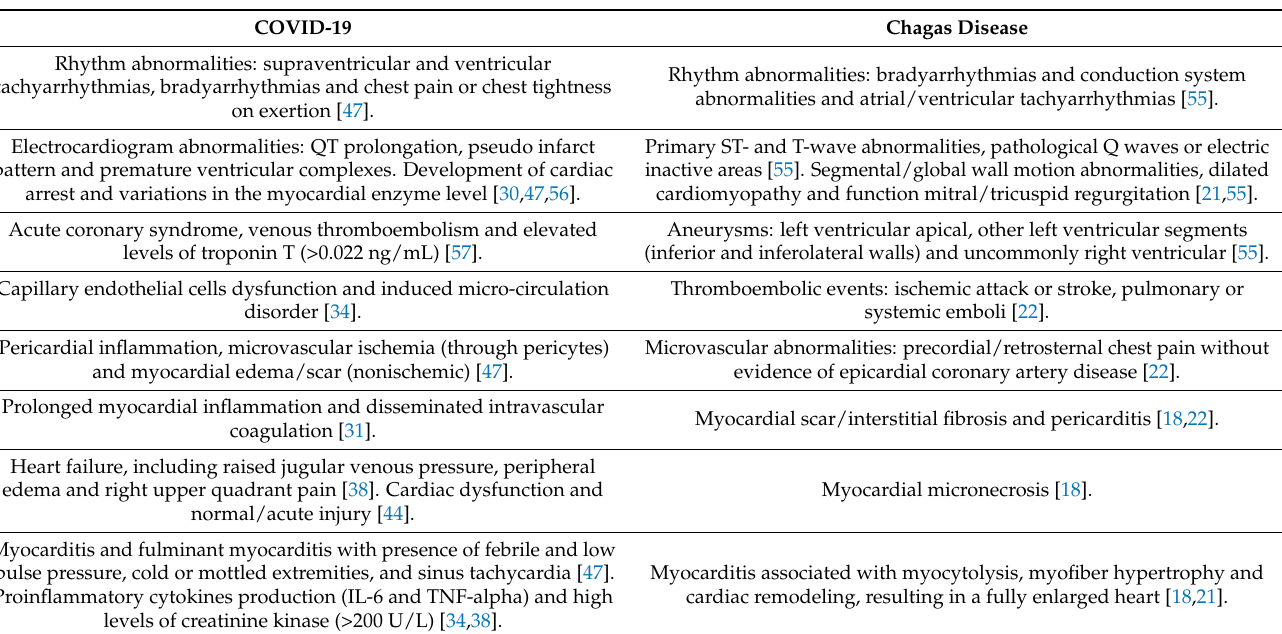
Table 1. Clinical features on cardiac affectations due to COVID-19 and Chagas disease. COVID-19 Chagas